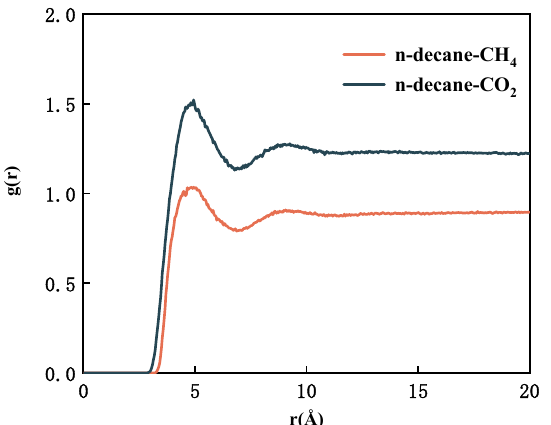
Figure 12. Radial distribution function between n-decane-CH 4 and n-decane-CO 2. in the system at 313.3 K, 11.14 MPa.